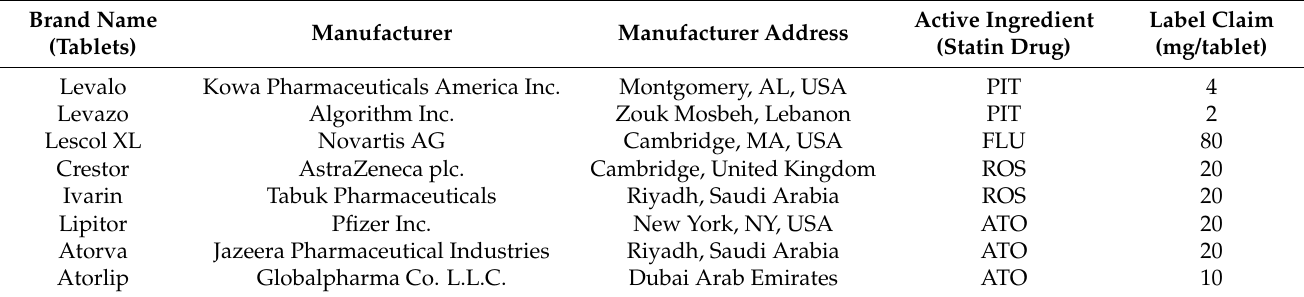
Table 8. The pharmaceutical tablets of the investigated